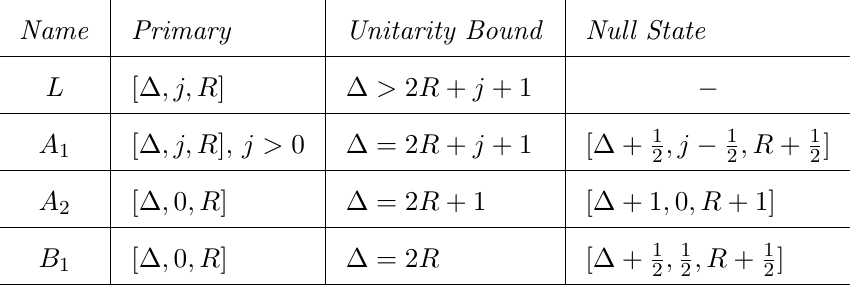
Table 1 . Shortening conditions in one-dimensional N = 2